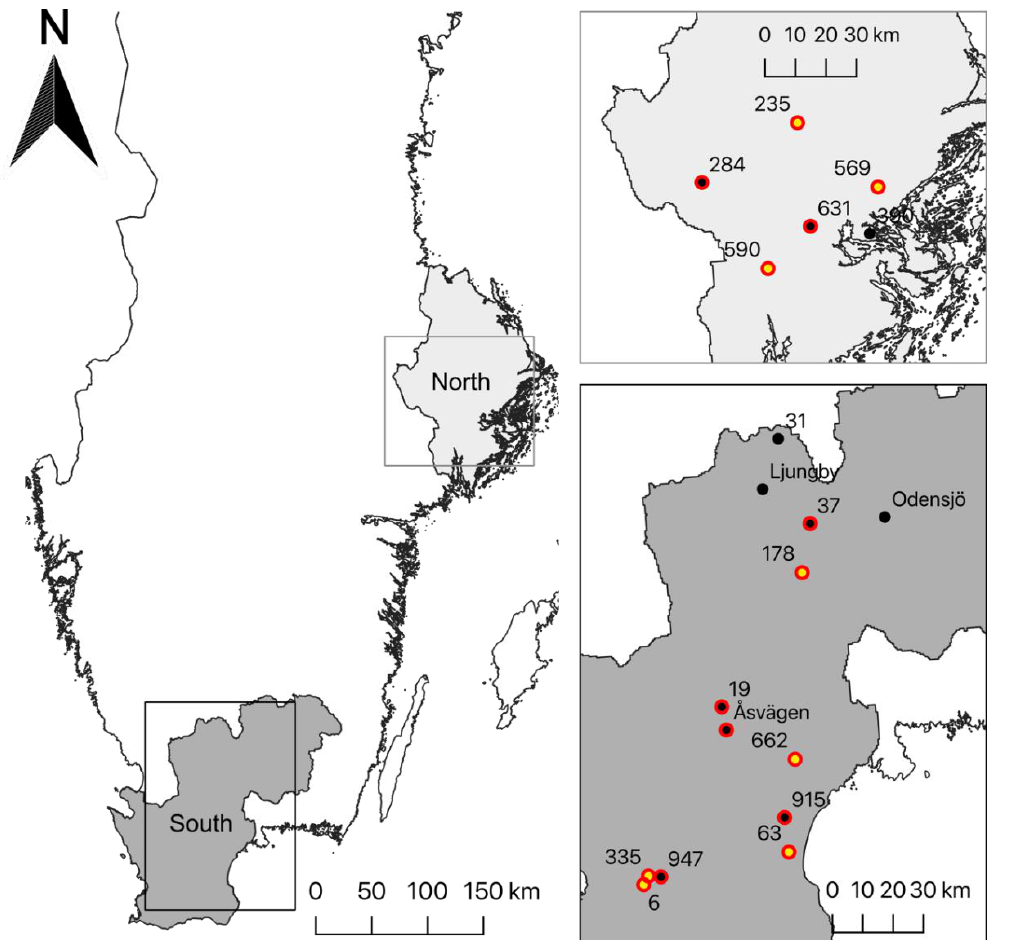
Figure 1. Map showing the 19 sites visited every two weeks during the two field campaigns (2017 and 2018). The sites are grouped into two regions, southern Sweden and the Stockholm region to the north. The points represent the location of the 19 sampled sites. The dots circled in red and the dots in yellow correspond to the sites where, respectively, individuals of P. confusa and A. urticae were used for genetic analyses.